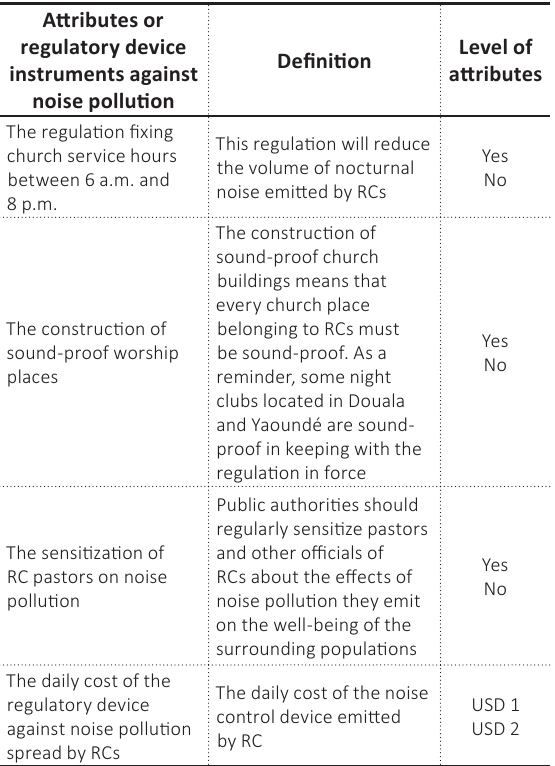
Table 1. Description of noise pollution